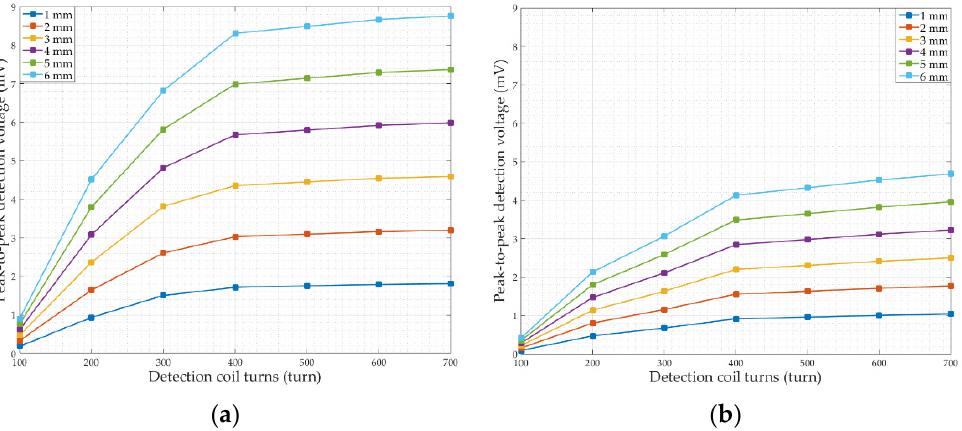
Figure 7. ( a ) Detection voltage amplitude of circumferential cracks with different turns of detection coil; ( b ) detection voltage amplitude of axial cracks with different turns of detection coil.